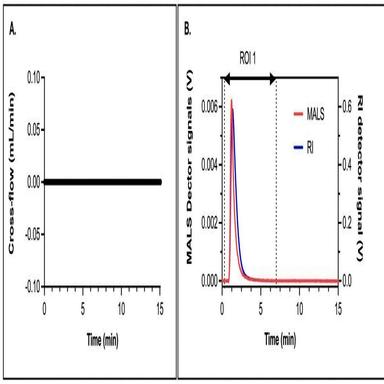
Determination of the dn/dc for unmodified and oxidized alginates using the AF4 system: A. Running method for dn/dc determination with cross-flow set to 0 mL/min; B. Example of selected region of interest (ROI) for dn/dc calculation in Postnova proprietary software (NovaFFF AF2000, version 2.1.0.5).